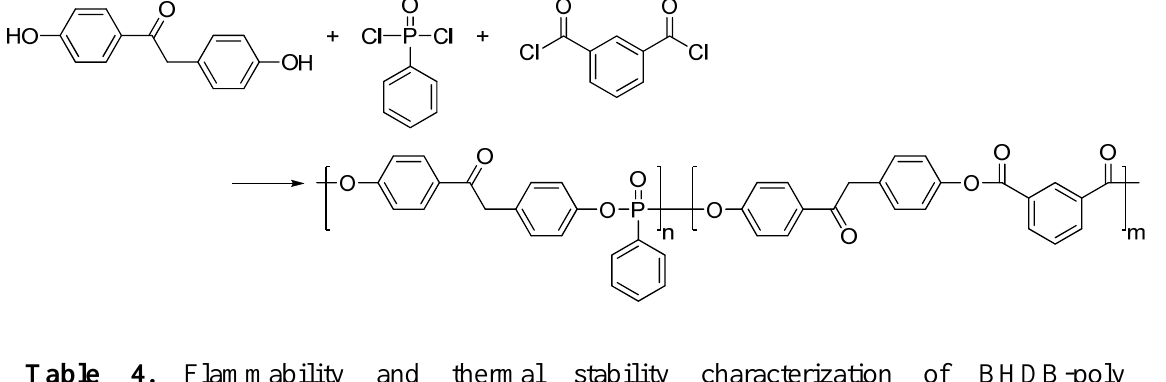
Table 4. Flammability and thermal stability characterization of